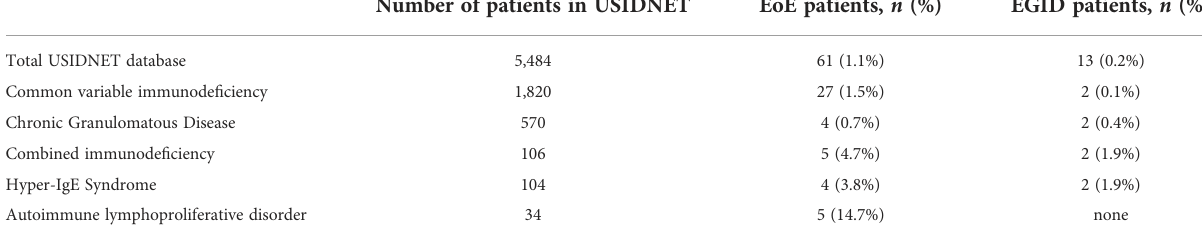
TABLE 2 Proportion of EoE and EGID in USIDNET